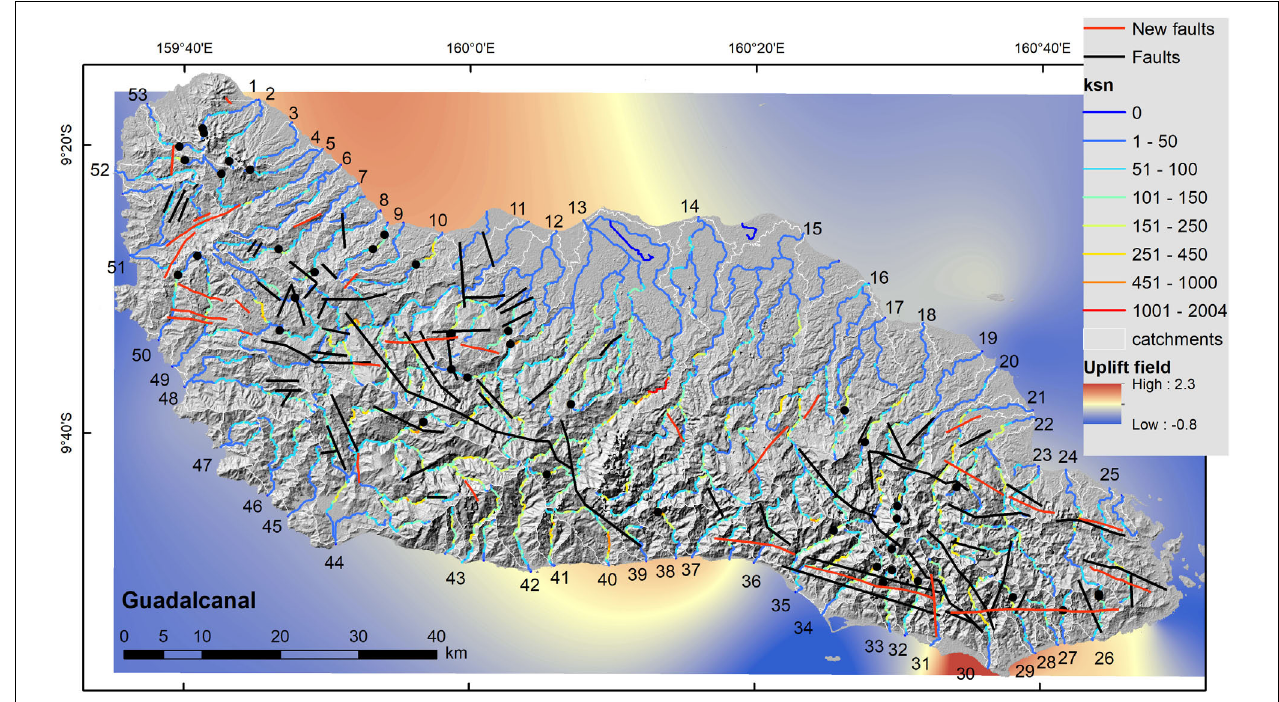
FIGURE 5 | Hillshade map derived from the 30 m SRTM DEM (USGS, 2019) for the island of Guadalcanal showing the rivers extracted for analysis shaded by k sn , identified slope-break knickpoints (black circles), major faults identified from analysis of the DEM and based upon existing mapping data (Department of Geological Surveys, 1969) and the interpolated uplifted